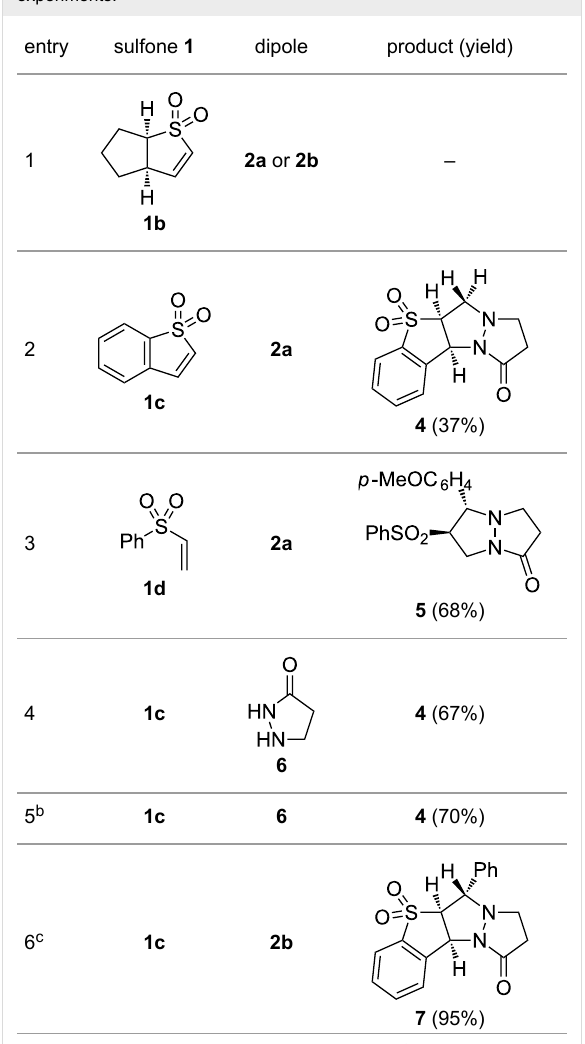
Table 3: Cycloadditions with bicyclic sulfones, and related control experiments.